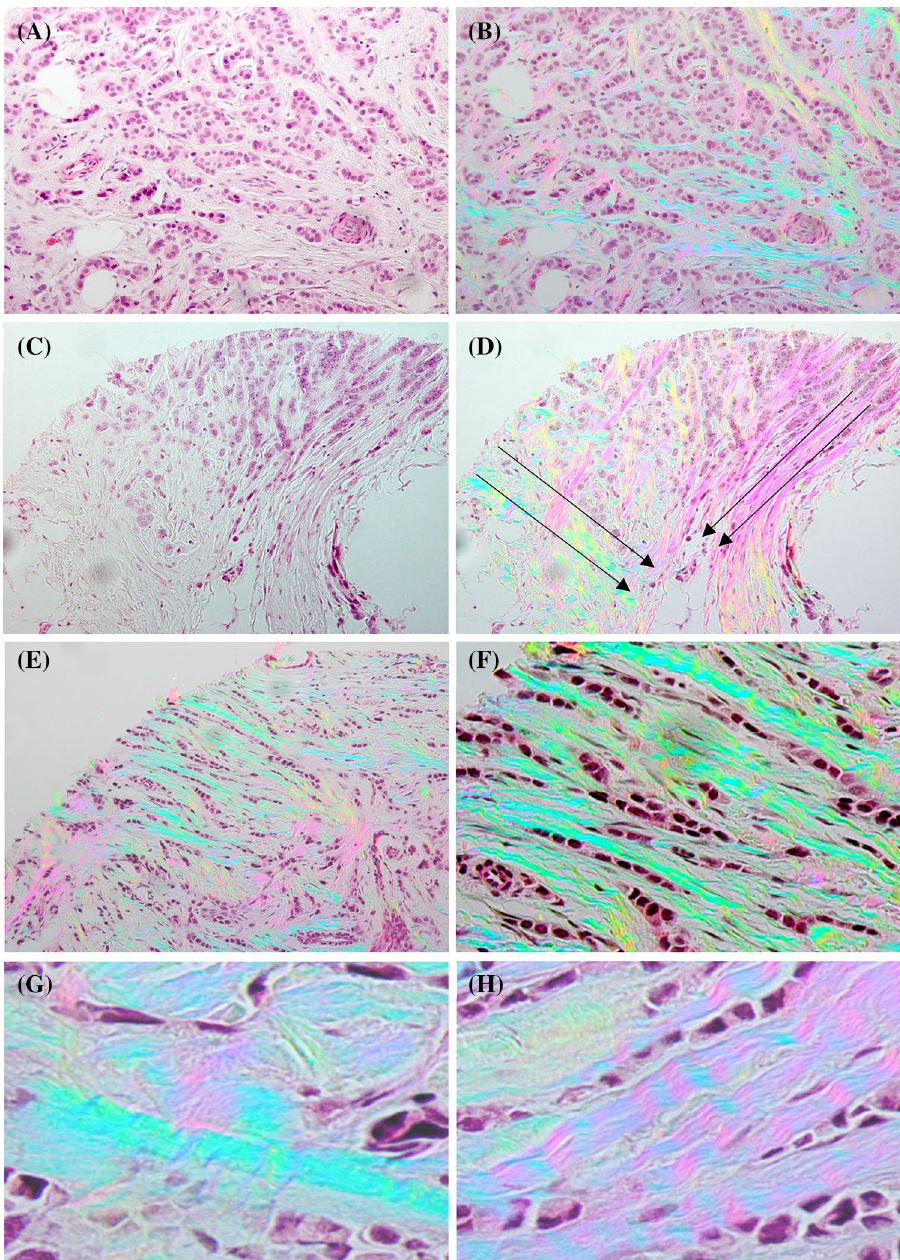
Figure 2. Collagen compartmentalizes the group of tumor cells that looks like a big mass of cells if one only looks at H&E images ( A , C ). ( D ) Shows how the cell migration direction in an invasive ductal adenocarcinoma (IDC) can be visualized using PPM while this information cannot be readily extracted by just looking at BF image of H&E stained tissue ( C ). ( E ) and ( F ) Show that the difference in fiber thickness doesn’t change the color and color is only related to the fiber orientation (all blue fibers with different thickness) diameters flowing from top left corner to the bottom right corner are depicted as green. ( G ) and ( H ) Show curvy fibers result in periodic changes and this can be used as a comparison between straight and curvy fibers. The tissue area represented in images ( A ) to ( E ) is 1384 × 1038 µm, the area in image ( F ) is 692 × 519 µm and in images ( G ) and ( H ) is 346 × 259 µm. Images shown are purposely not post-processed in order to represent what the pathologist would see looking through the